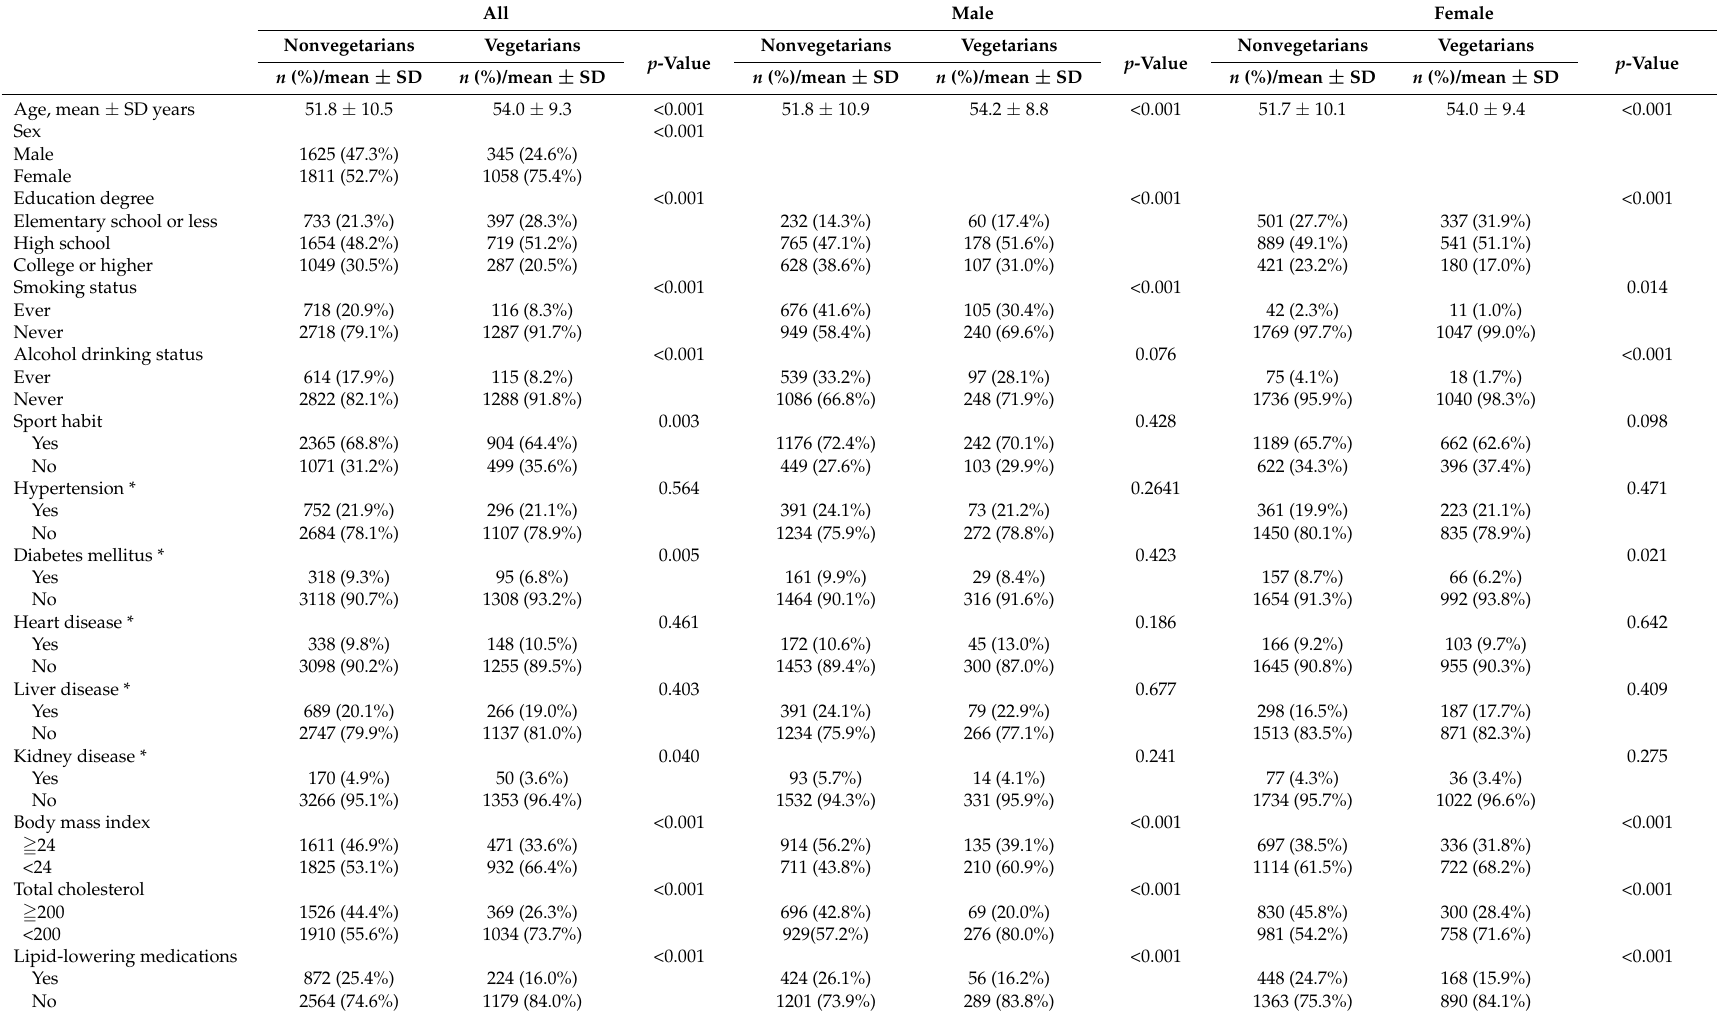
Table 1. Baseline characteristics of vegetarians and